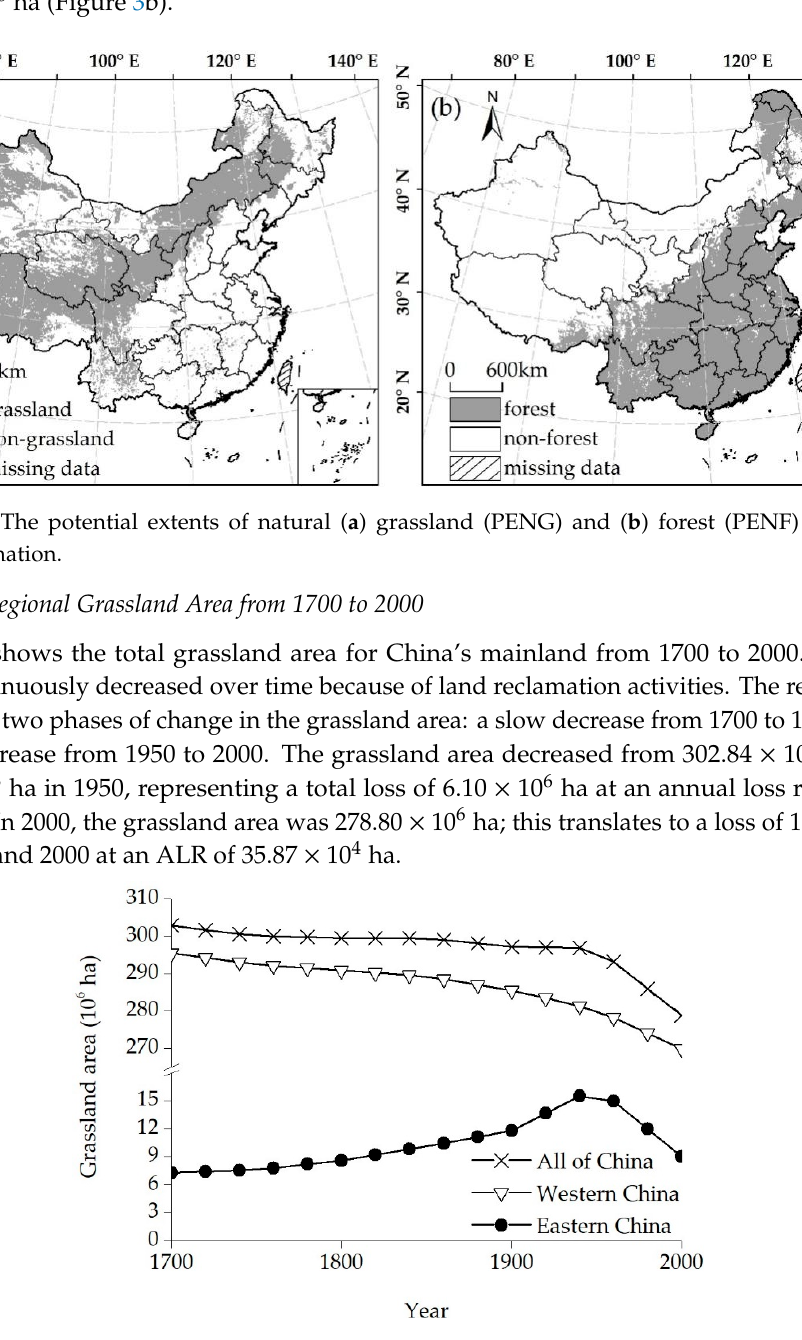
Figure 4. Changes in the total and regional grassland areas from 1700 to 2000.